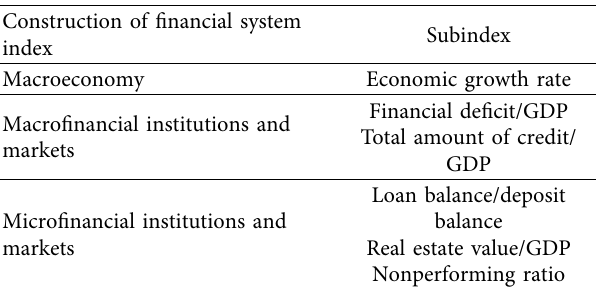
Table 2: Construction of financial system